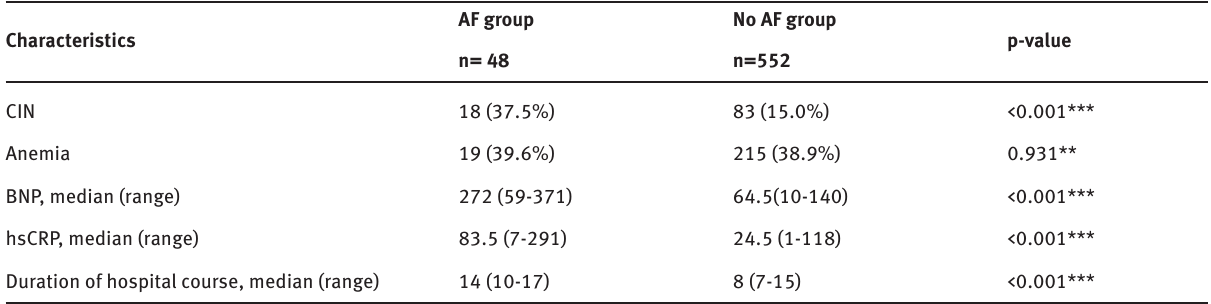
Table 2: In-hospital prescription of drugs Variable